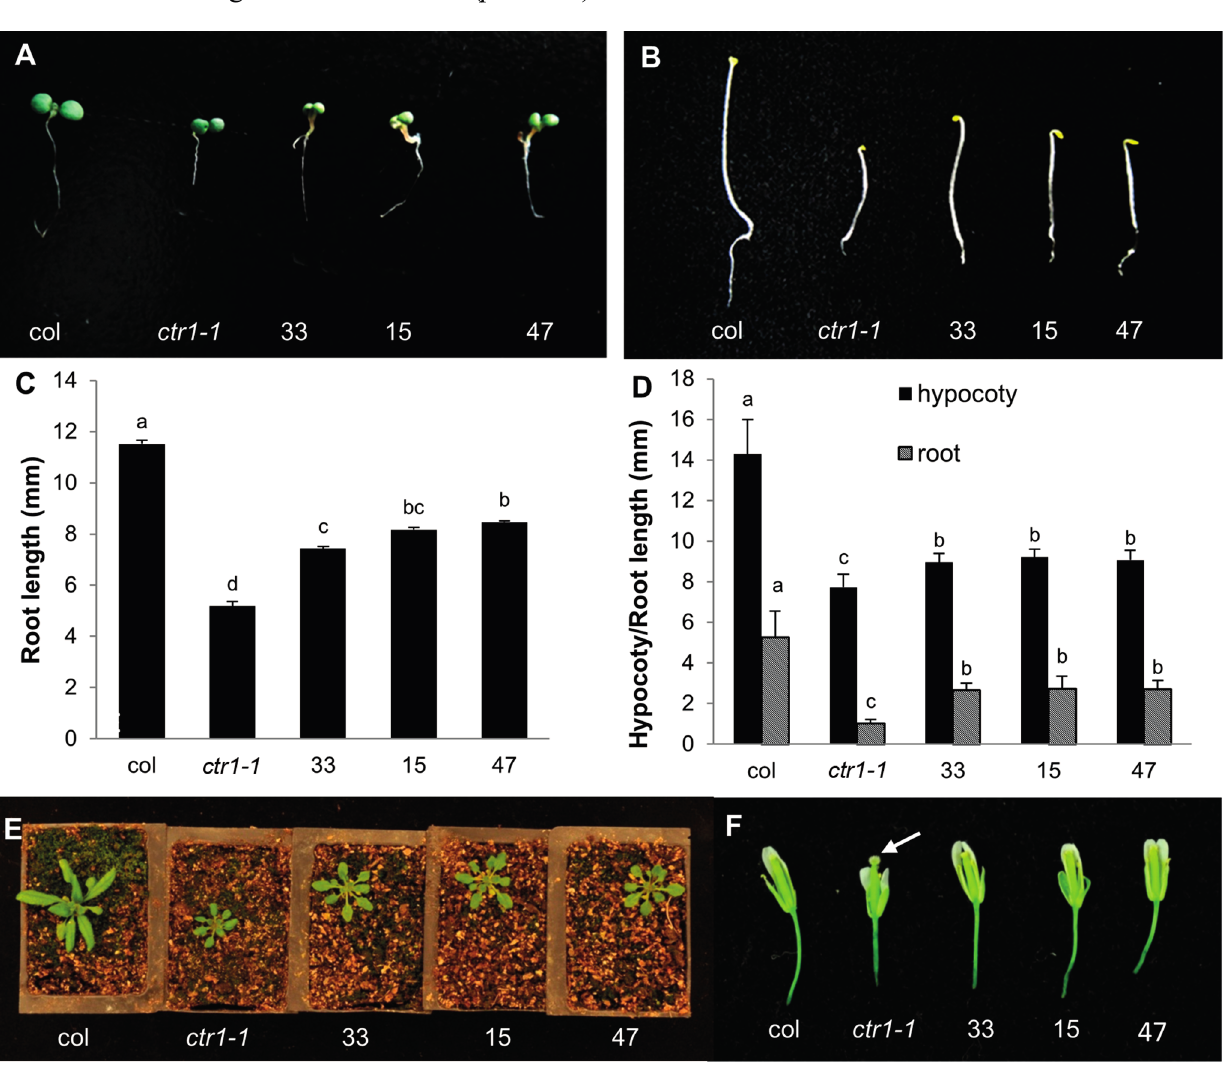
Figure 5. Phenotypes of the transgenic CsCTR1 -overexpressing lines (33, 15 and 47) compared with that of Arabidopsis wild type (col) and the ctr1-1 mutant. ( A ) Five-day-old seedlings grown in the light; ( B ) Five-day-old etiolated seedlings; ( C ) Root length of the seedlings grown in the light; ( D ) Root and hypocotyl length of the etiolated seedlings; ( E ) Adult plants at the rosette stage; and ( F ) Phenotypes of the gynoecium in developing flower, the white arrow indicates the gynoecium protruding out of the unopened buds in ctr1-1 mutant. Error bars on each column indicate standard deviation from ten replicates. The statistical significance was determined by Duncan’s multiple comparison tests. Different letters above bars indicate significant differences ( p < 0.05). The same letter indicates no significant difference ( p <